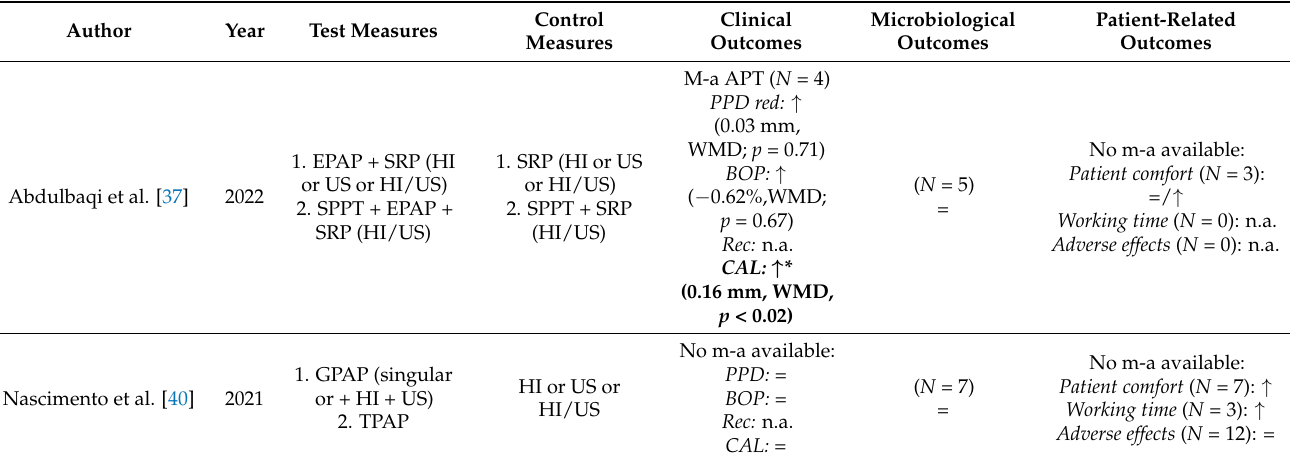
Table 2. Results of the included systematic reviews on active periodontal therapy.(BOP: bleeding on probing reduction; CAL: clinical attachment level gain; EPAP: erythritol powder air polishing; GPAP: glycine powder air polishing; HI: hand instruments; M-a: meta-analysis; N: number of included studies; n.a.: not available; PPD red: periodontal pocket depth reduction; TPAP: trehalose powder air polishing; Rec: gingival recession; SPPT: simplified papilla preservation technique; SRP: scaling